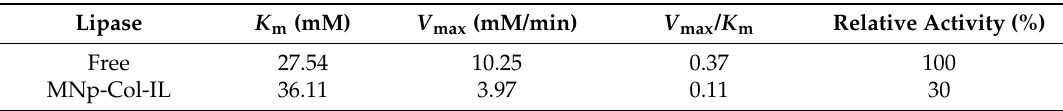
Figure 6. Lineweaver–Burk plots of free lipase and MNp-Col-IL. Table 2. The kinetic parameters.